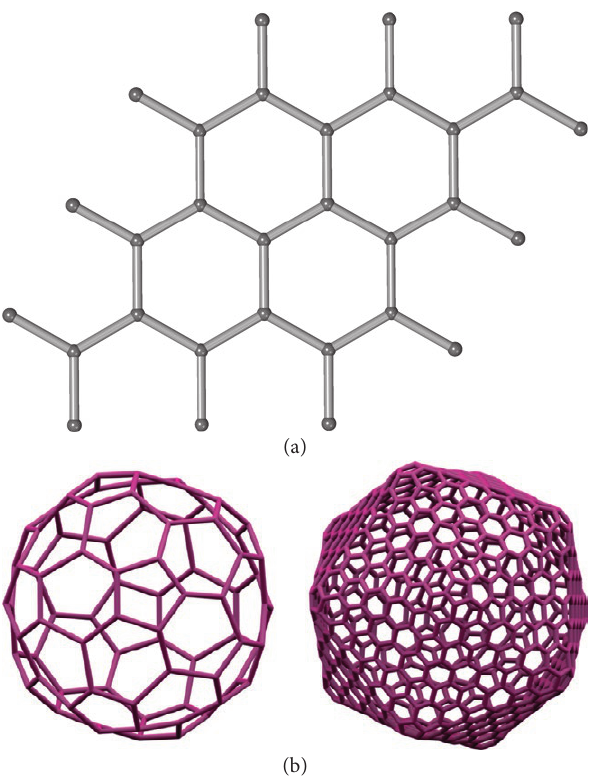
Figure 3. (a) The planar network of (three-connected) carbon atoms in graphite, (b) some (three-connected) fullerene networks (carbon atoms lie at each vertex): (L to R) C 60 and C 740 (courtesy of Myfanwy